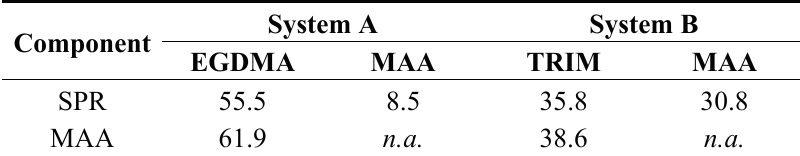
Table 2. Time engaged in hydrogen bond formation (% of simulation) between species in Systems A and